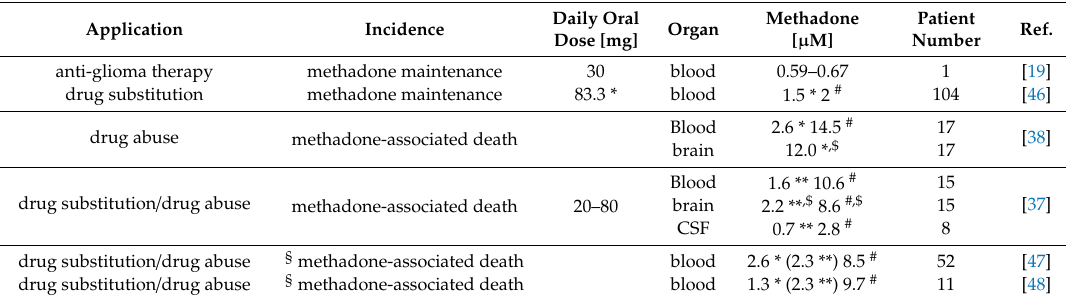
Table 1. Clinically observed methadone tissue